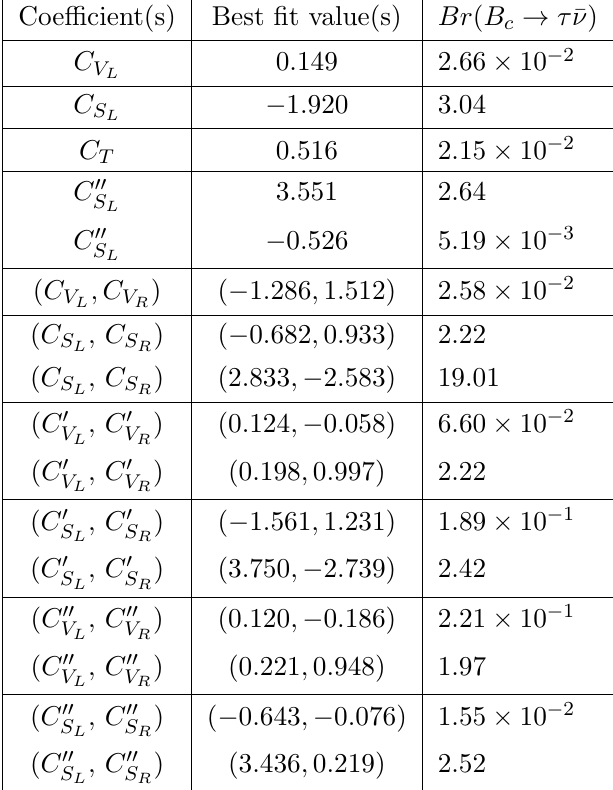
(cid:20) 4 : 8. We also min measurement and the R J=